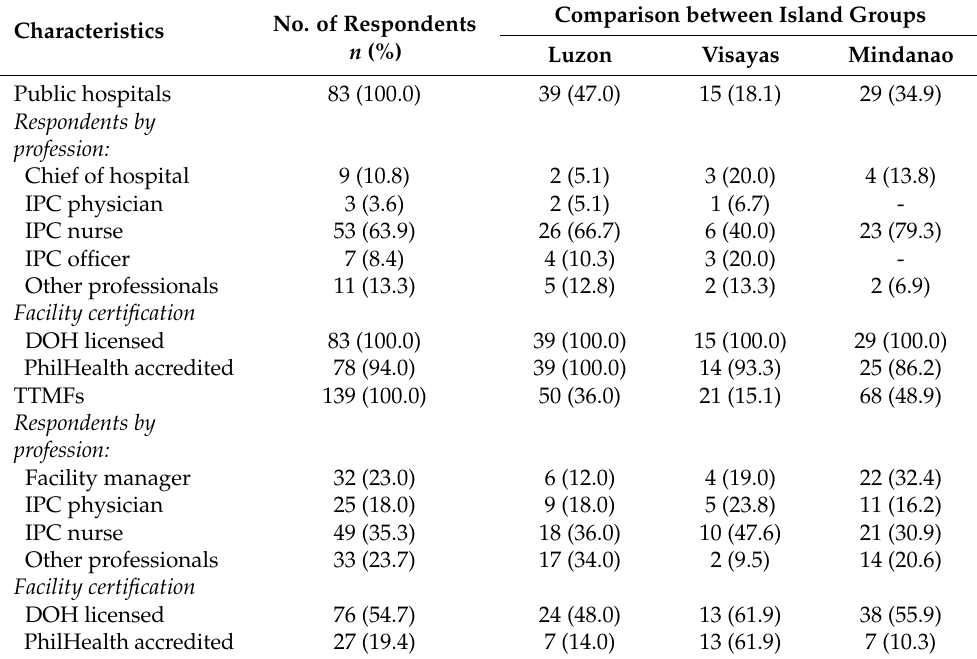
Table 1. Demographic characteristics of health facilities and associated